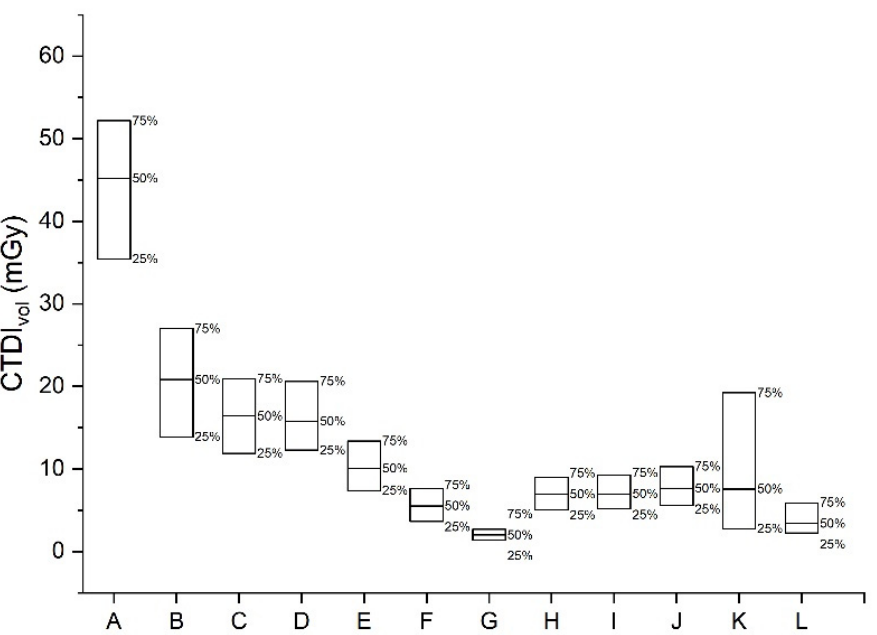
Neck CT with contrast, F: Chest CT with contrast, G: Low dose screening chest CT, H: Abdomen- Figure 1. The 25th and 75th percentile DRLs and 50th percentile (achievable dose) CTDI vol values for